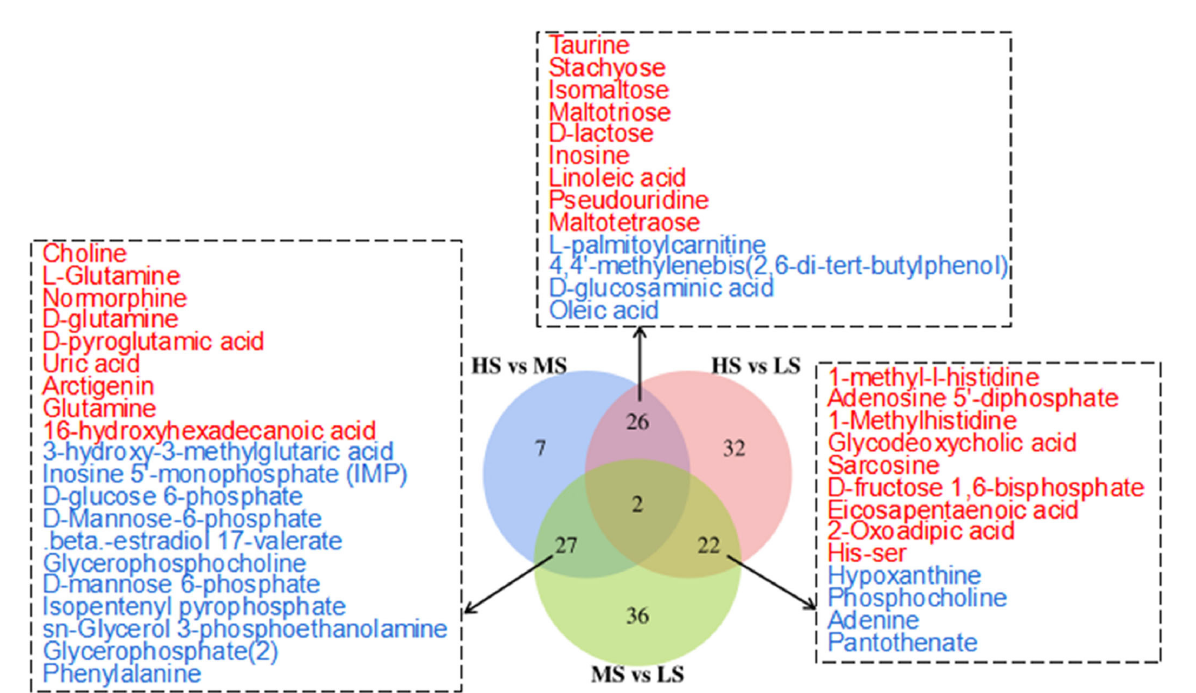
FIGURE3 Venn diagram illustrates the overlap of differential metabolites connected with the KEGG metabolic pathways among the three comparisons (HS vs. MS; HS vs. LS; MS vs. LS) in the longissimus lumborum of Tibetan sheep. The color red and blue represent the upregulation and downregulation of metabolites,